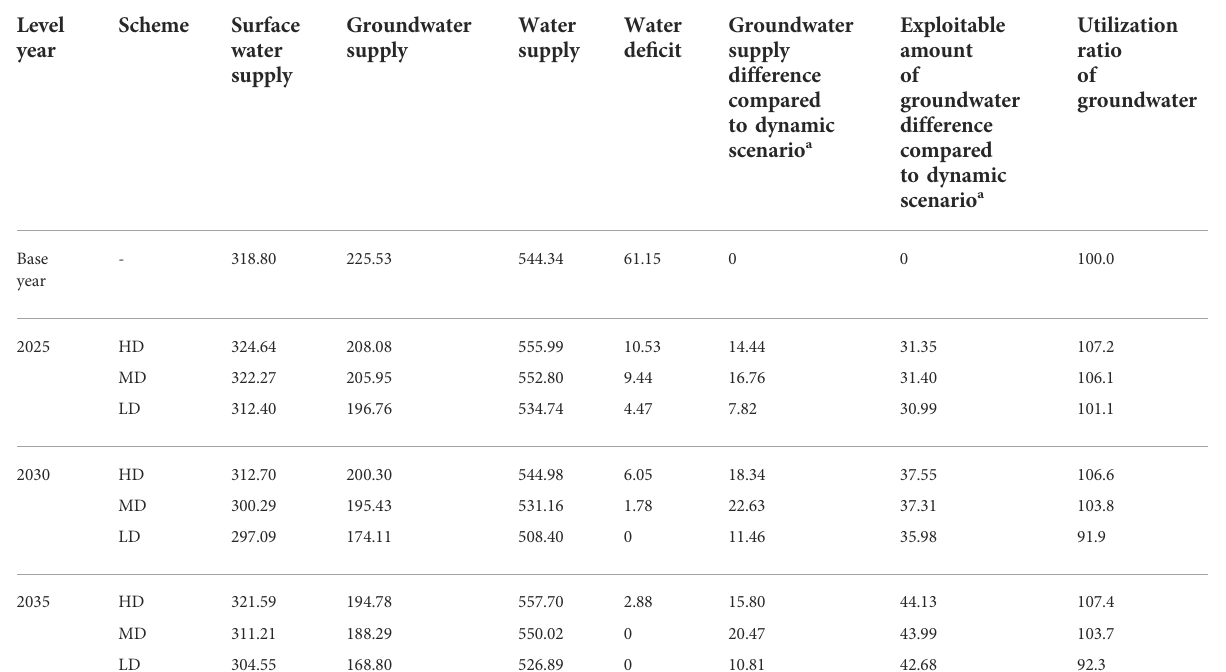
TABLE 4 Water resource allocation based on the constant scenario (amount: 10 6 m 3 , ratio: %).